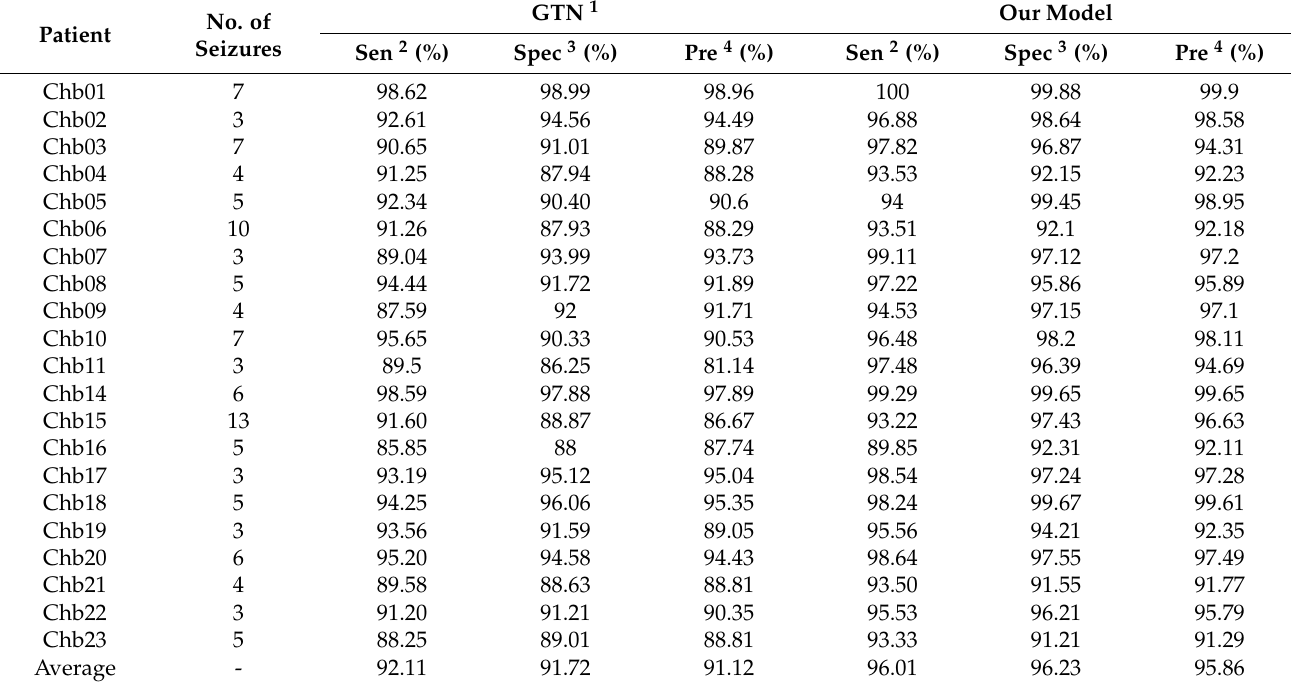
Table 3. The comparison between the performance of the GTN 1 and our